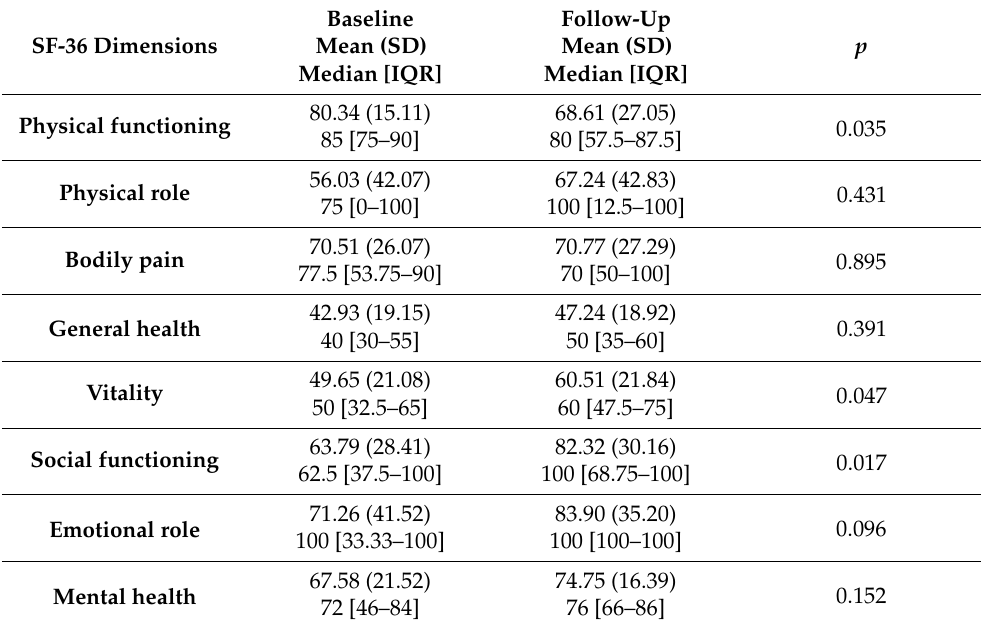
Table 2. Comparison of SF-36 scores at baseline and follow-up in the group of survivors.